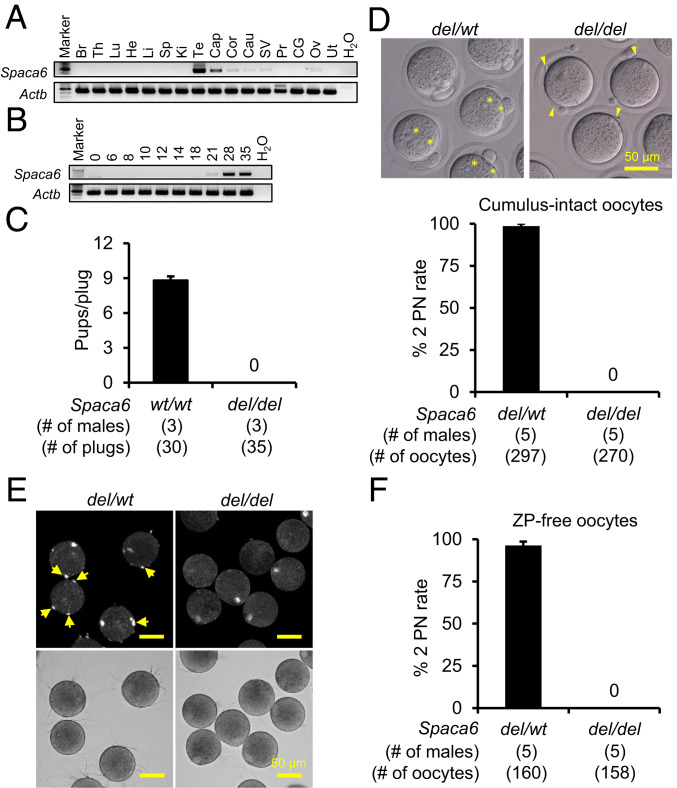
Analyses of Spaca6 del/del male mice. (A) Detection of Spaca6 mRNA in various mouse tissues and organs by RT-PCR. (B) Detection of Spaca6 mRNA in mouse testes at various postnatal days by RT-PCR. (C) Analysis of the fecundity of Spaca6 del/del males by mating tests. Males were caged with wt/wt females for 10 wk, during which copulation plugs were examined and litter sizes were recorded. The wt/wt males were examined, in the meantime, as a positive control. While the wt/wt mating pairs delivered 264 offspring with an average litter size of 8.8 ± 2.4, the del/del males failed to sire offspring. (D) IVF analysis of the ability of Spaca6 KO spermatozoa to fertilize cumulus-intact oocytes. (Upper) After 6 h of incubation, Spaca6 control spermatozoa successfully inseminated oocytes indicated by the formation of 2 PN (asterisks), whereas the KO spermatozoa were accumulated in the perivitelline space and cannot fertilize the oocytes (yellow arrowheads). (Lower) The control spermatozoa gave a high fertilization rate of about 97%. In contrast, no 2 PN eggs were observed when incubated with KO spermatozoa. (E) Analysis of the ability of Spaca6 KO spermatozoa to fuse with the oocyte plasma membrane. Spermatozoa were incubated with Hoechst 33342-preloaded oocytes for 30 min, and the membrane fusion was determined by transfer of Hoechst 33342 fluorescence signal to fused sperm heads (yellow arrows). The lower bright-field images indicate both control and KO spermatozoa could bind normally to the oocyte surface. (F) IVF analysis of the ability of Spaca6 KO spermatozoa to fuse with ZP-free oocytes. While about 97% of the control sperm-inseminated oocytes formed 2 PN, KO spermatozoa could not fuse with ZP-free oocytes.